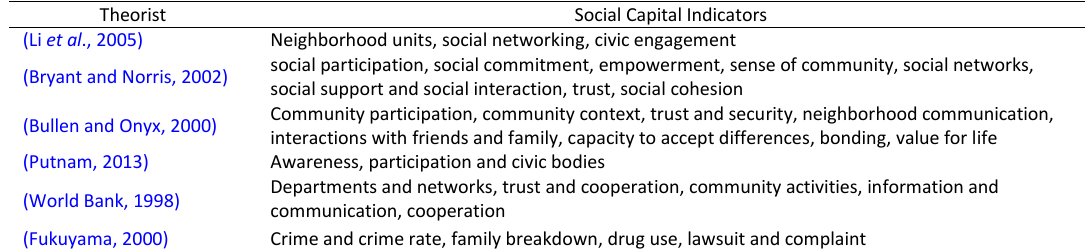
Table 1. Social capital indicators